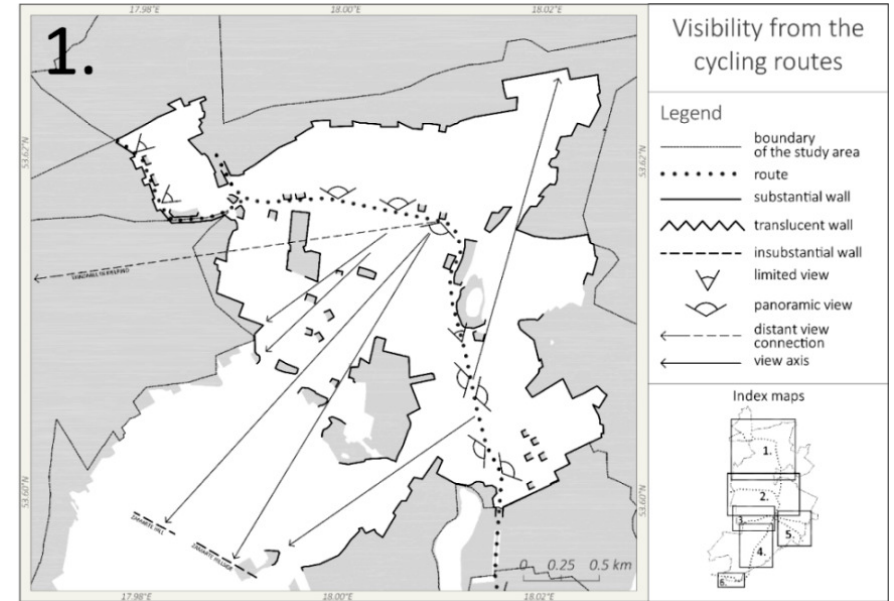
Figure 4. Analysis of landscape exposure of route 1 and characteristics of the limited fields of view. landscape subtypes adopted in Poland (see columns 2A